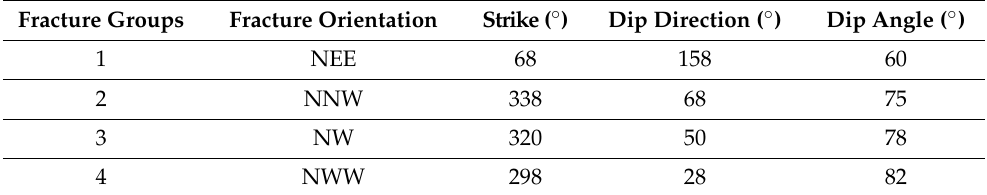
Figure 6. Diagram of computational domain and boundary conditions. Table 1. Statistical average values of structural plane in JPSHP. Table 1. Statistical average values of structural plane in